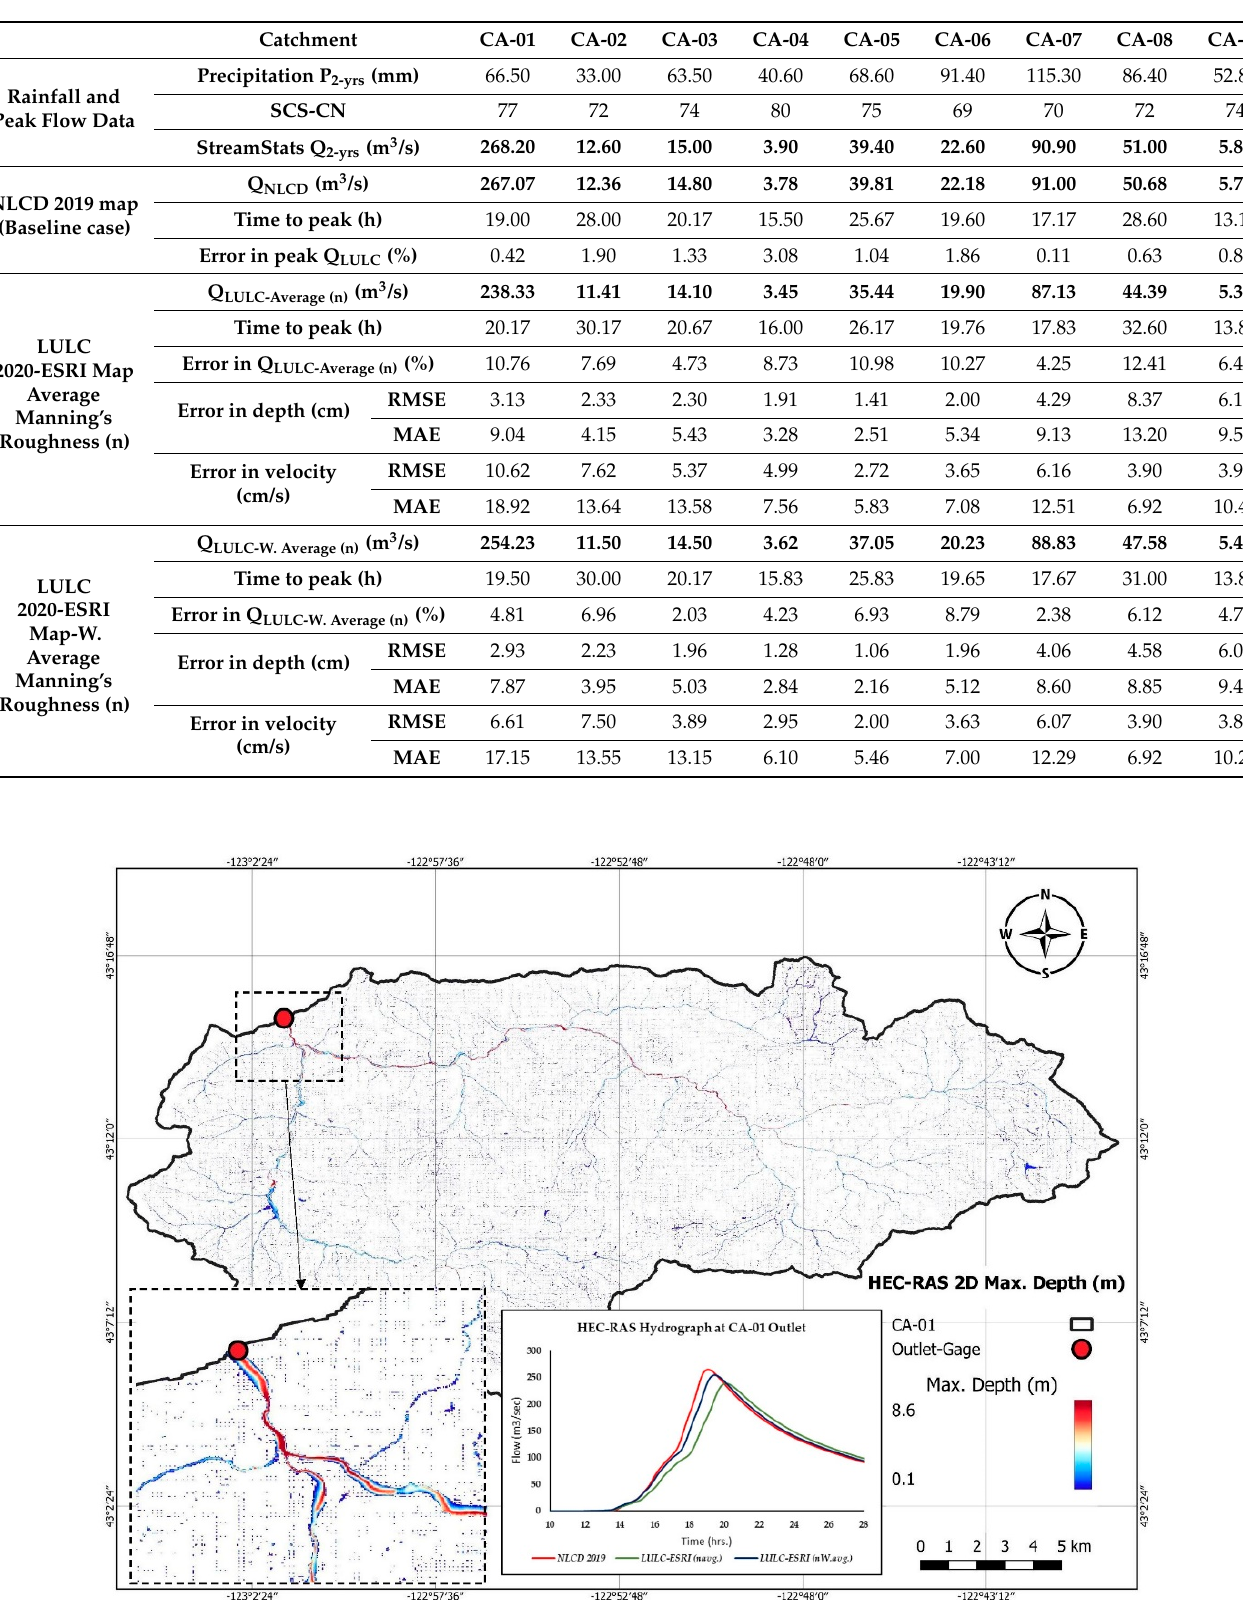
Table 8. Calibration data and analysis results for a 2- years return period.